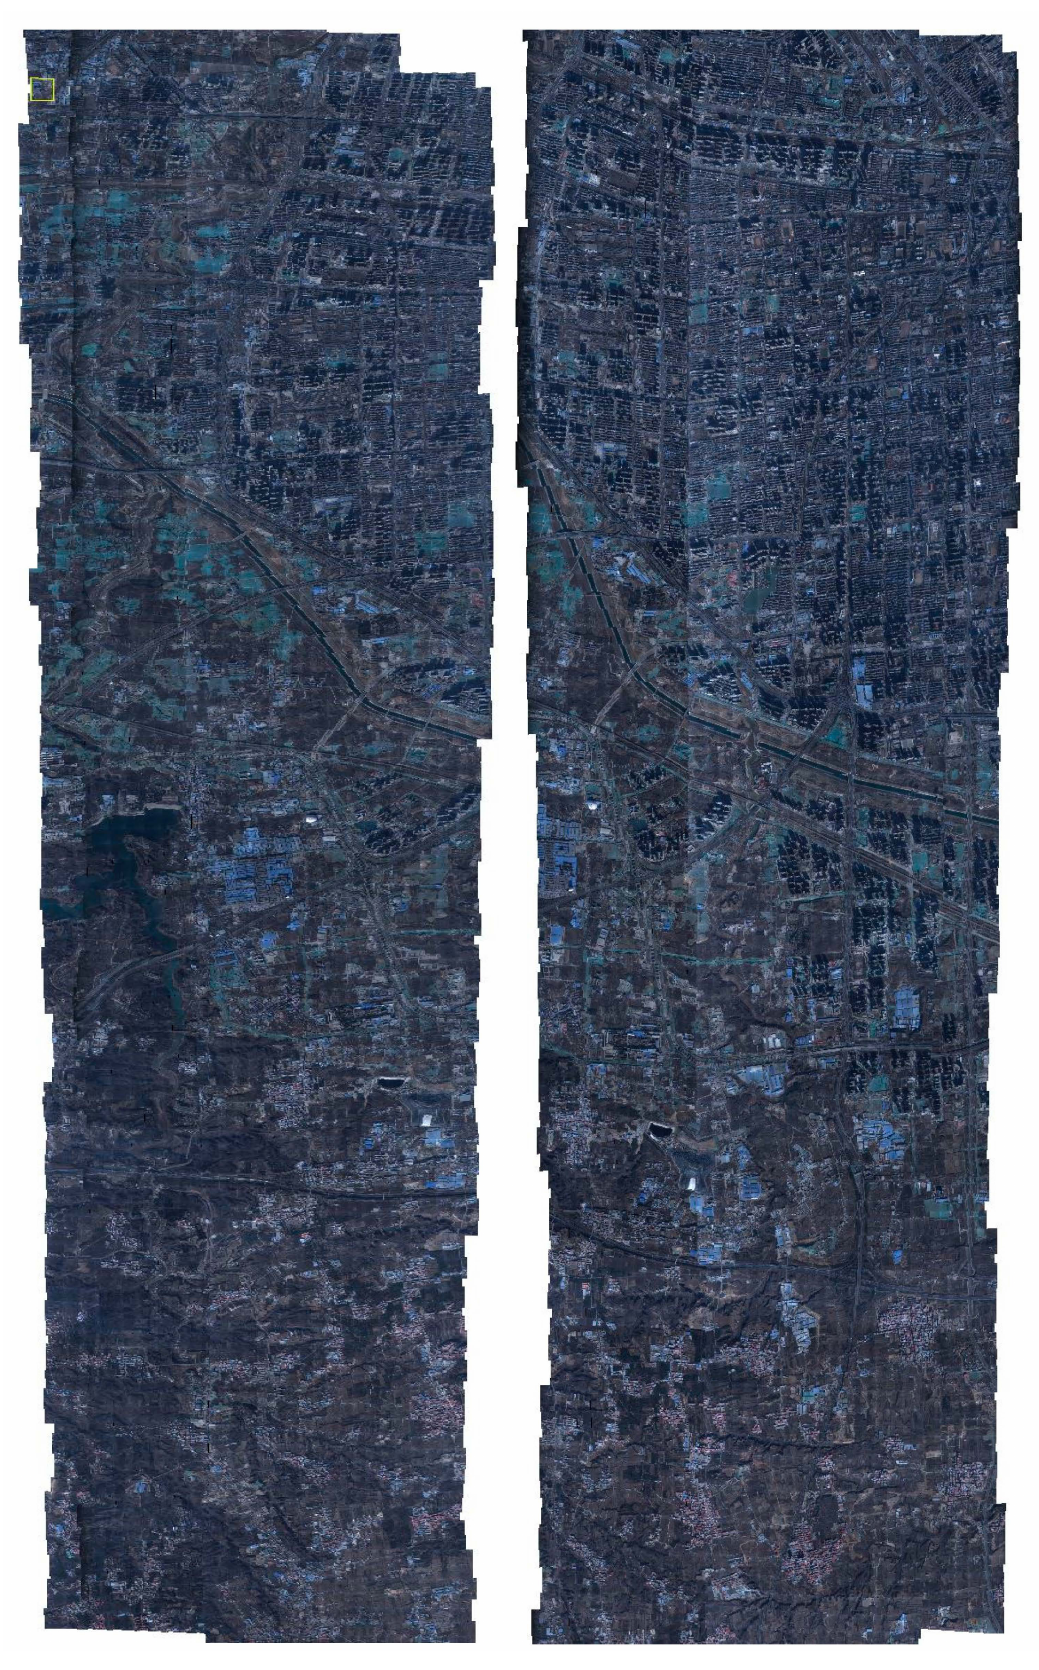
Figure 7. VisionMap Flight